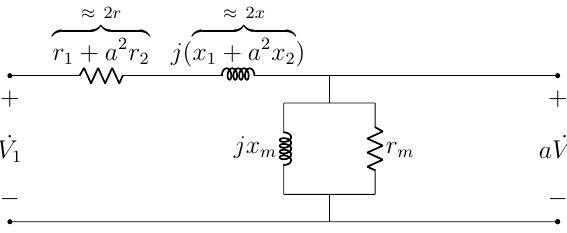
Figure 2. Standard transformer steady-state